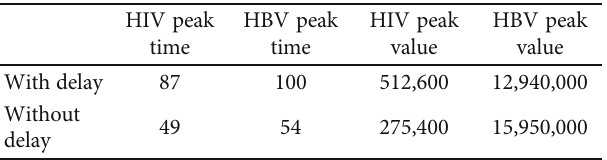
Table 2: Peak values and time for HIV and HBV, with and without